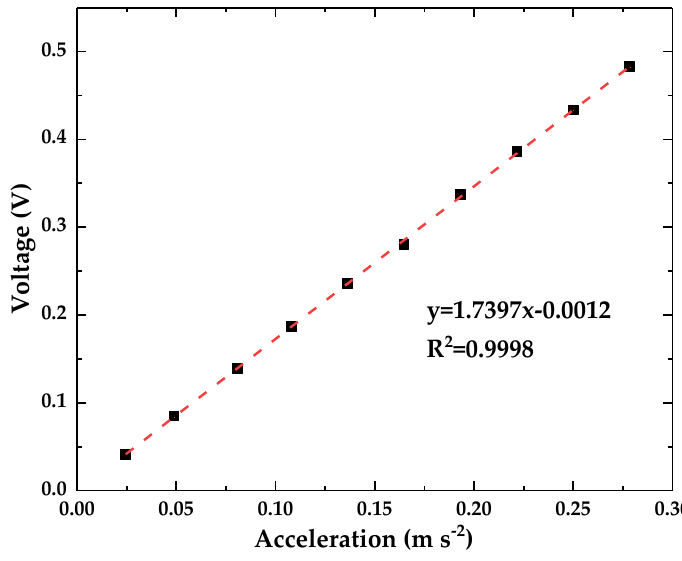
Figure 8. The sensitivity of the optical accelerometer.